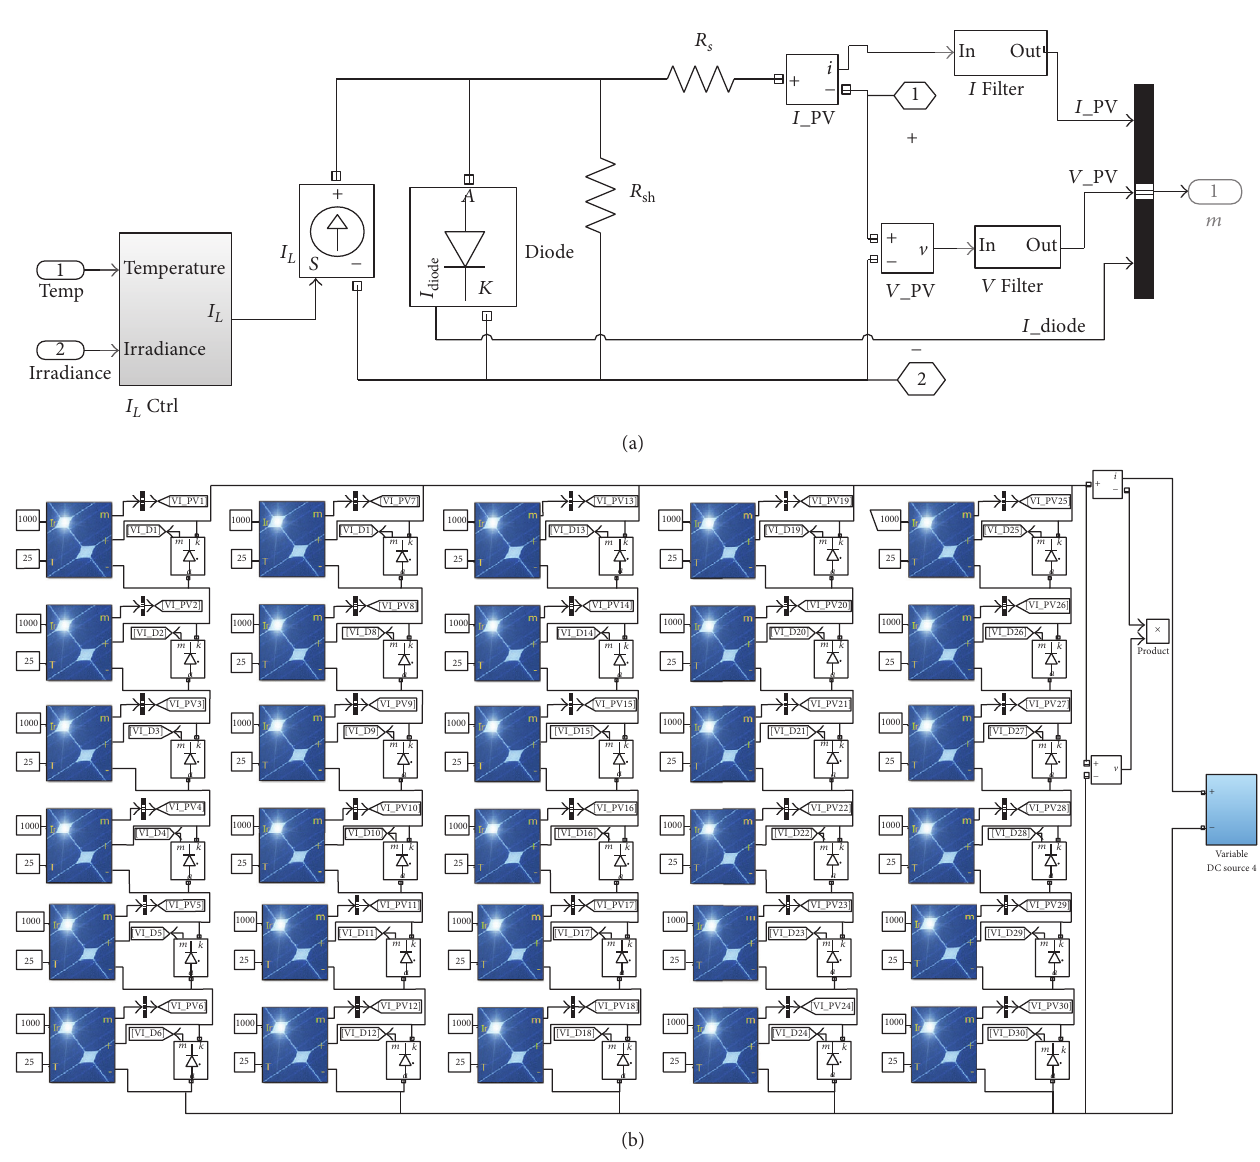
Figure 3: (a) Equivalent circuit of a solar and (b) a schematic diagram of a PV farm system with 6 × 5 modules.